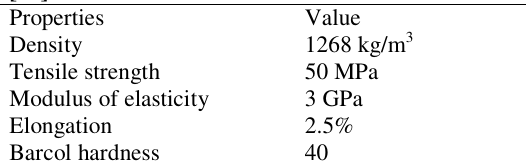
Physical and mechanical properties of (UP) resin [16].